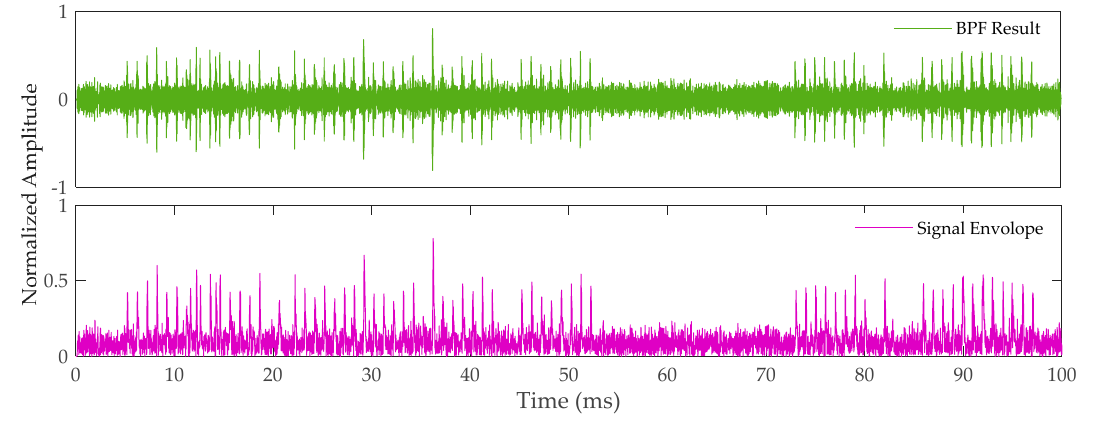
Figure 9. Band-pass filter (BPF) result and signal envelope.